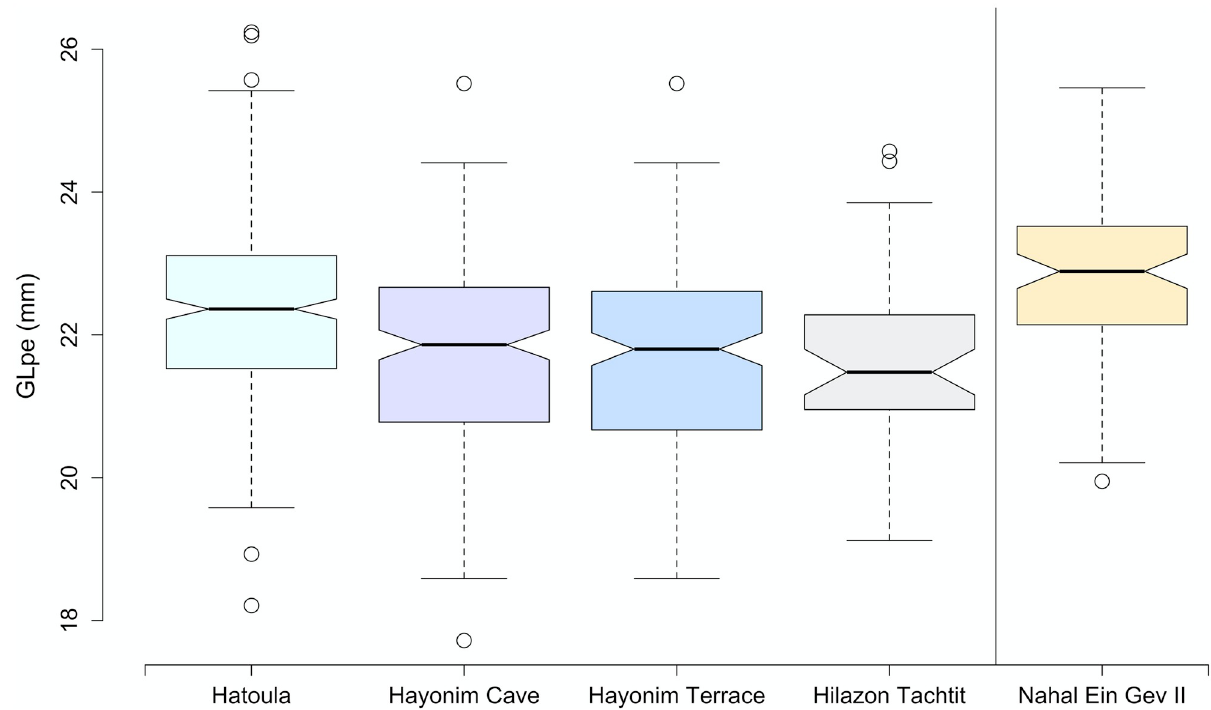
Fig 5. Notched boxplots indicating the range, mean and 95% confidence interval for the GLpe of the second phalanx for the Late Natufian sites of Hayonim Cave, Hayonim Terrace, Hatoula, Hilazon Tachtit and the Jordan Valley site of Nahal Ein Gev II which is presented as an external comparison. el-Wad Terrace is not included due to small sample size (n =